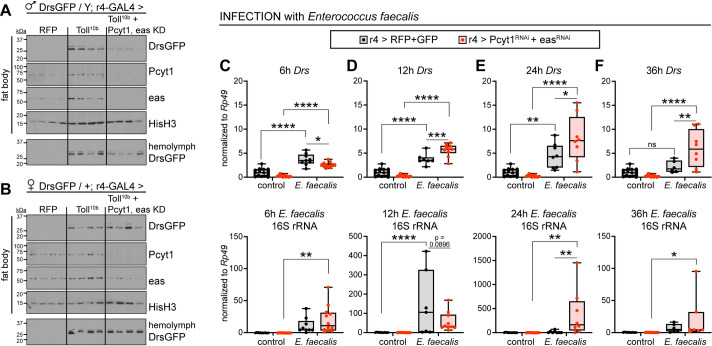
Pcyt1 and easily shocked support the innate immune response.(A, B) Western blot analysis of DrsGFP, Pcyt1, and eas protein levels in fat bodies (top four panels) and DrsGFP in hemolymph (bottom panel) from male (A) and female (B) late third instar larvae expressing RFP or Toll10b alone or with simultaneous knockdown of Pcyt1 and easily shocked using r4-GAL4. Histone H3 levels are shown as loading controls for fat body blots. For hemolymph blots, equivalent volumes of diluted hemolymph (equal to 50 nL of neat hemolymph) were loaded. (C-F) Top: Whole-animal transcript levels of Drs, and bottom: transcript levels of Enterococcus faecalis 16S rRNA in larvae expressing RFP+GFP or Pcyt1RNAi+easRNAi in fat body under control of r4-GAL4 at 6–36 hours post infection with Enterococcus faecalis. Both Drs and Enterococcus faecalis 16S rRNA were normalized to Rp49. Uninfected control samples for each genotype were collected throughout the time course, pooled, and are plotted on each graph. All groups were normalized to the pooled, uninfected RFP+GFP samples, n = 6-15/group. *p ≤ 0.0310, **p ≤ 0.0097, ***p ≤ 0.0007, and ****p < 0.0001 versus infected RFP+GFP or versus uninfected controls of the same genotype, as indicated. Data are presented as means ± SD. p values were determined by one-way ANOVA with the Tukey-Kramer multiple comparisons test (C-F).